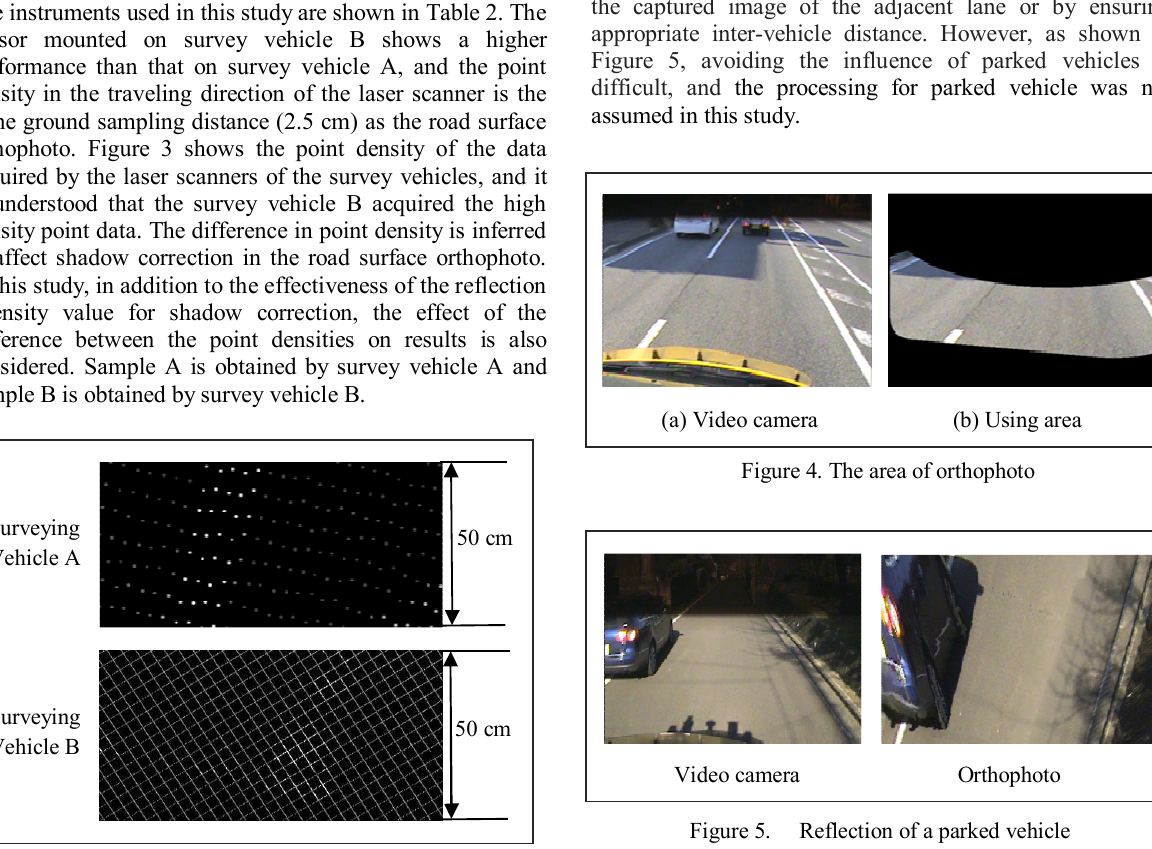
Figure 3. Point density of laser data